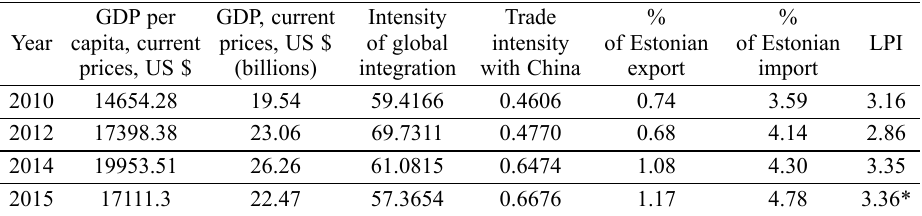
Table 4. Evaluation of the potential of Estonia as a participant of the NSR